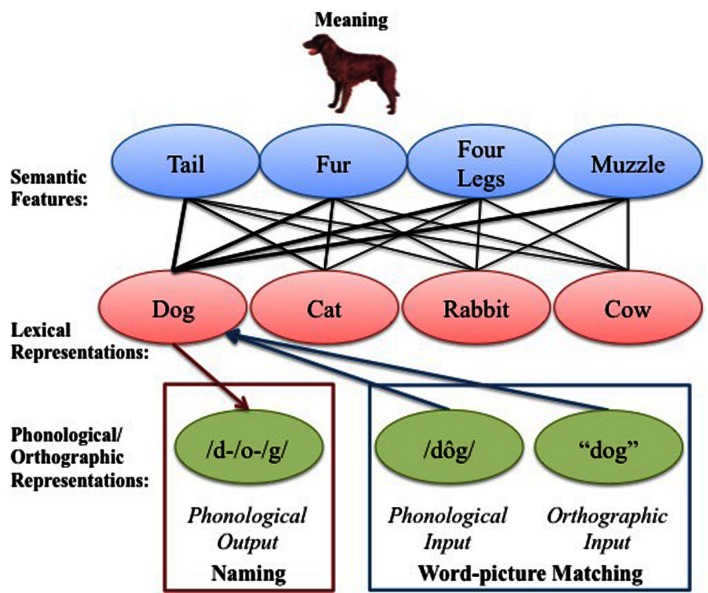
The basic structure of the language system. It is hypothesized that naming and matching words to pictures require access to shared semantic and lexical level representations, but the output vs. input levels of representation differ across the tasks (cf. Caramazza, 1997; Levelt et al., 1999).